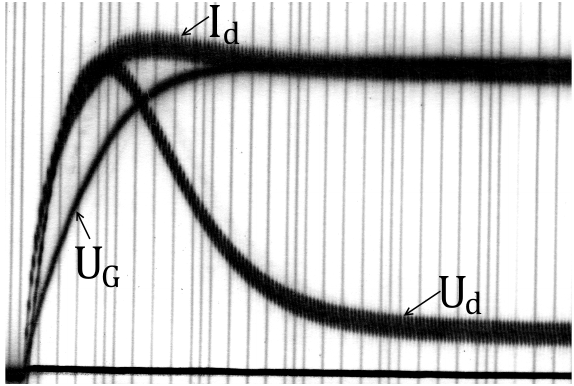
Figure 4. Experimental oscillogram of a DC generator with the effect of eddy currents. U G —output voltage of DC generator (generator’s EMF); U d —filtered excitation voltage; I d —filtered excitation current.